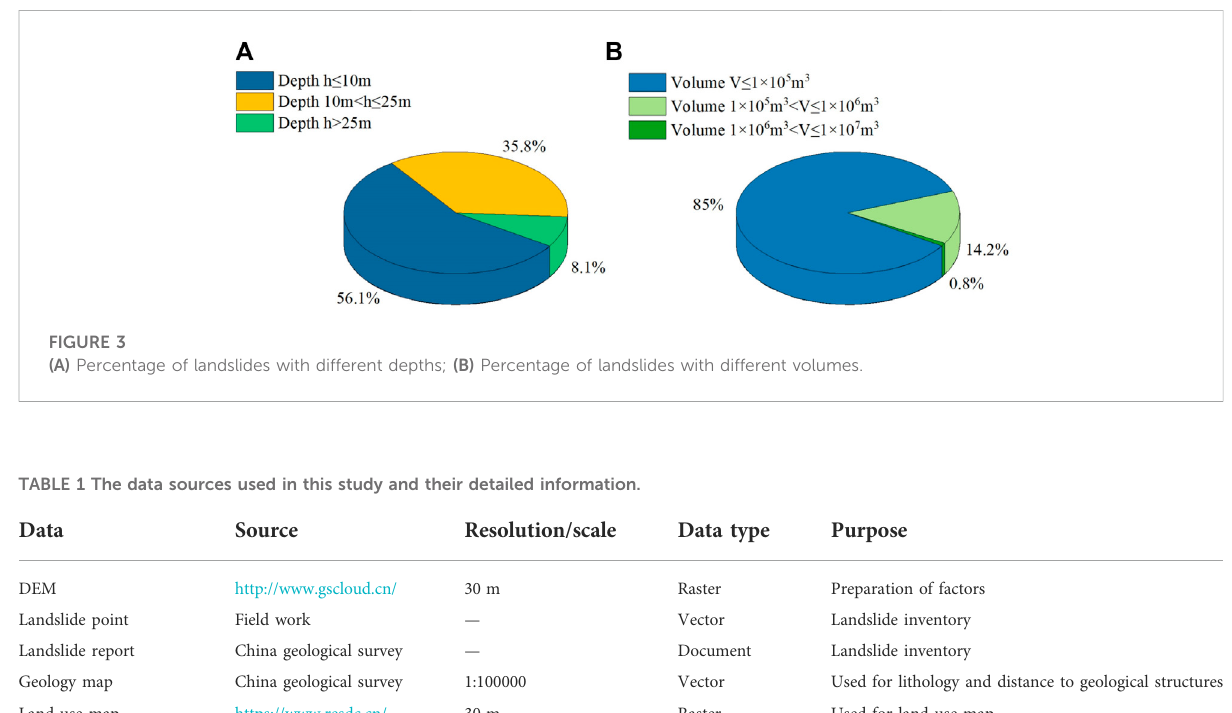
and erosion. The values of plan curvature in the area varies from − 2.825 to 4.227. Pro fi le curvature (Figure 4E): This factor controls the acceleration and deceleration of fl ows through slopes so that the fl ow process can be in fl uenced. It was also derived from the DEM, and the values are from − 3.908 to 4.199. Surface roughness (Figure 4F): Surface roughness refers to the ratio of ground surface area to its projected area and is a macro indicator re fl ecting the surface morphology (Goetz et al., 2015). It was obtained by calculating the ratio between the surface area of a slope and the projected area in the vertical direction. It is also equal to the standard deviation of slope (SDS) (Atkinson